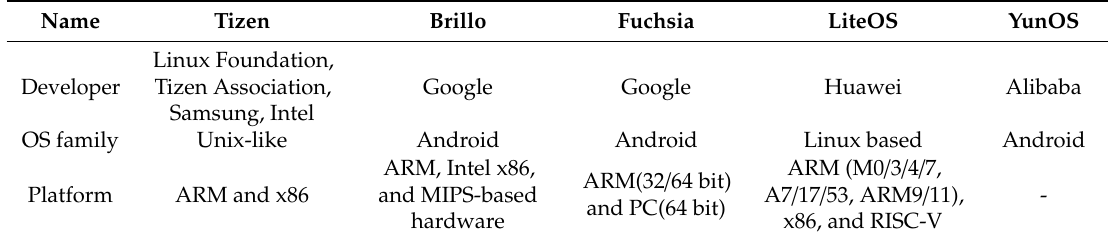
Table 1. Examples of analysis environments that support IoT / embedded